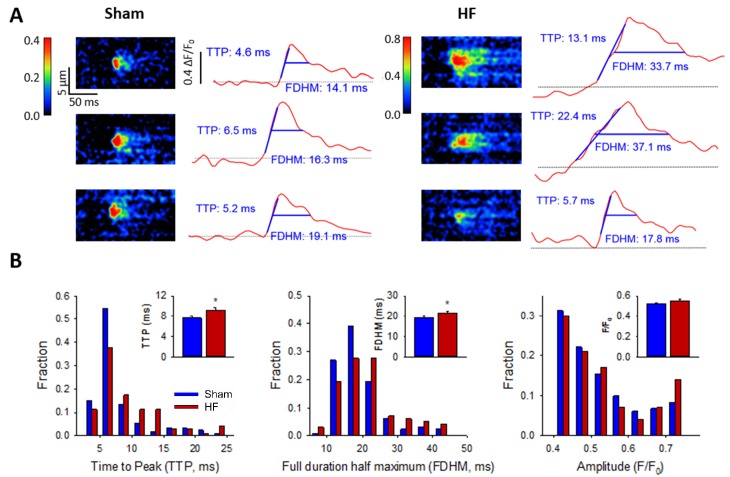
Ca2+ spark kinetics are slowed in HF.(A) Representative line-scan images of Ca2+ sparks in Sham and HF, selected from the cell-wide scans presented in Figure 3E. Temporal profiles (right panels) show that spark kinetics were generally tightly constrained in Sham, with low values for both time to peak (TTP) and duration (full duration at half maximum, FDHM). Although many sparks were also brief in HF cells, a subset of sparks exhibited slowed kinetics. (B) Distributions of measurements for TTP and FDHM were right-shifted in HF, and mean values were significantly increased. Spark magnitudes tended to be larger in HF than Sham. (nsparks = 130, 100 from 75, 72 cells in Sham, HF; *=P < 0.05 vs Sham).